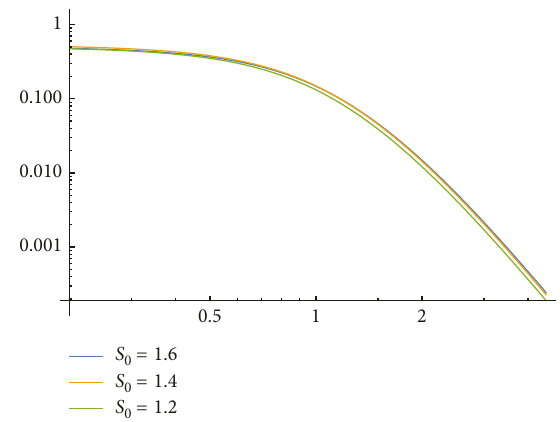
Figure 4: Log-log plot of the distribution (18) for I � 1 and three � 1 . 2 , 1 . 4 , 1 . 6. different S 0